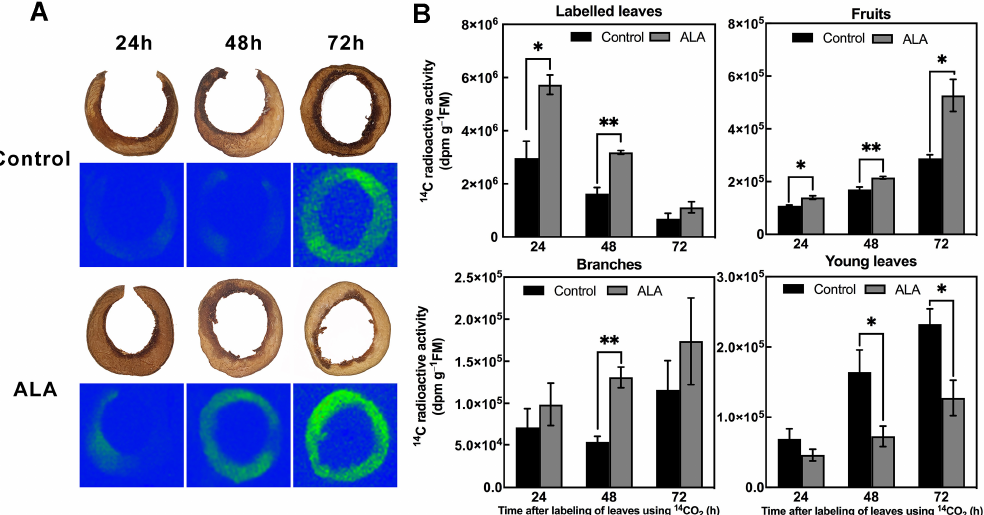
Figure 2. ( A ) The images of autoradiography of flesh discs after leaf 14 C labelling. ( B ) Comparison of 14 C radio activity of different organs of peach after leaf labelling. The data are the means ± SE from three biological replicates. Bars with * indicate the di ff erences signi fi cant according to t -test. (* p < 0.05, ** p < 0.01).